Question: Give a one-sentence summary of this figure.
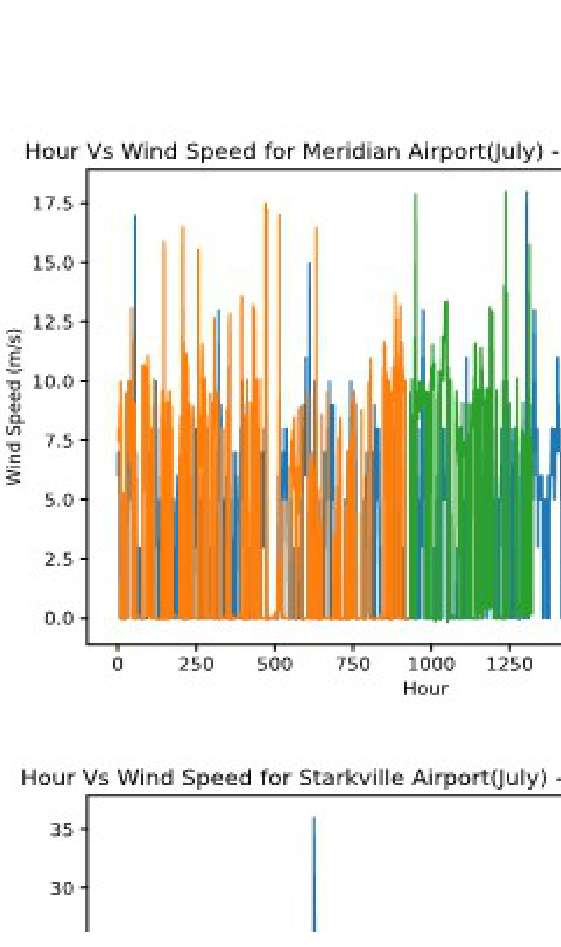
Answer: MERIDIAN VS. STARKVILLE FOR THE MONTH OF